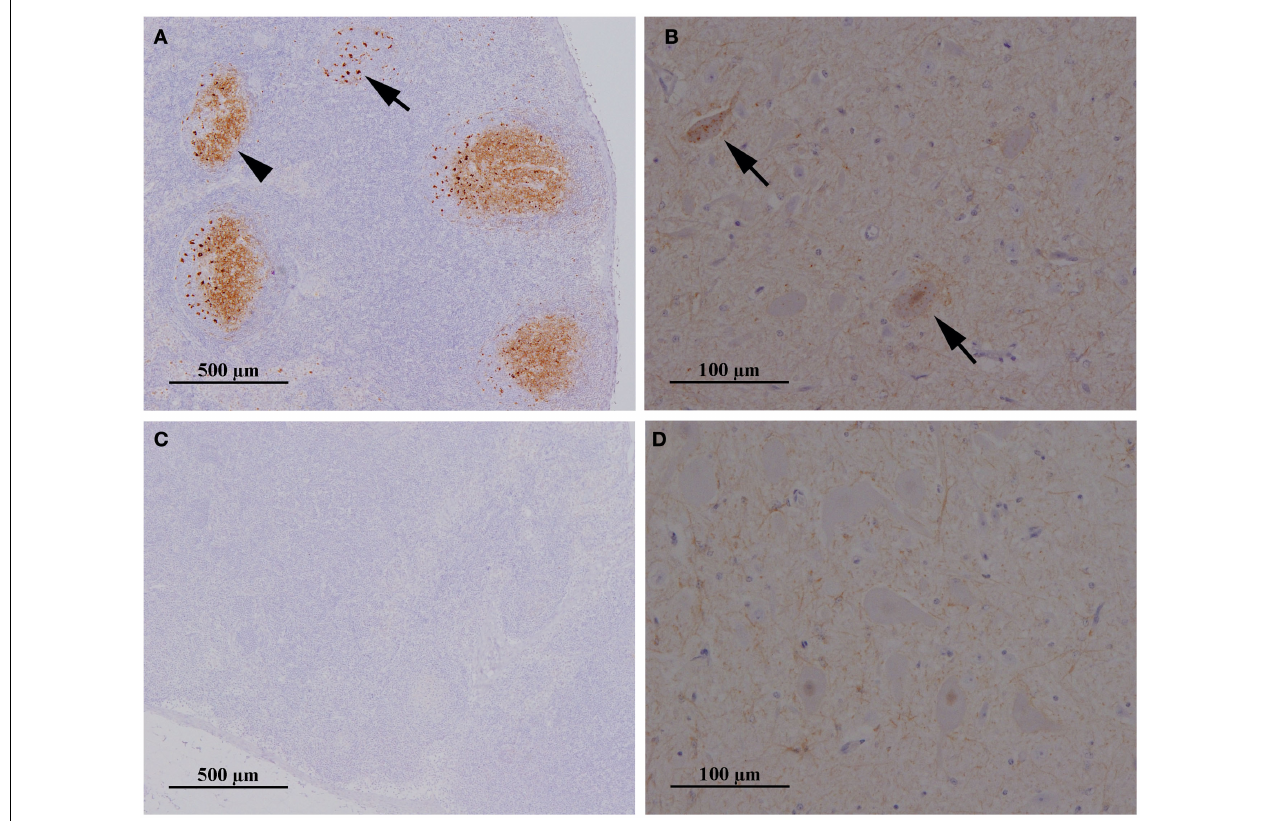
FIGURE 1 | Presence and absence of PrP Sc in the lymph node and brainstem of two sheep exposed to contaminated furniture on pasture in paddock 1 . Immunohistochemical examination of mesenteric lymph node (A,C) and brainstem at the level of the obex (B,D) taken from sheep 25/13 (A,B) and 38/13 (C,D) , respectively. Antibody: R145. Sheep 25/13 presents with PrP Sc in tingible body macrophages (A) , black arrow, and the network of follicular dentritic cells (A) , black arrowhead, in follicles of the lymph node and also in neurons in the dorsal motor nucleus (parasympathetic nucleus) of the vagus nerve (B) , black arrows, whereas PrP Sc is neither detectable in lymph node (C) nor in brainstem (D) of sheep